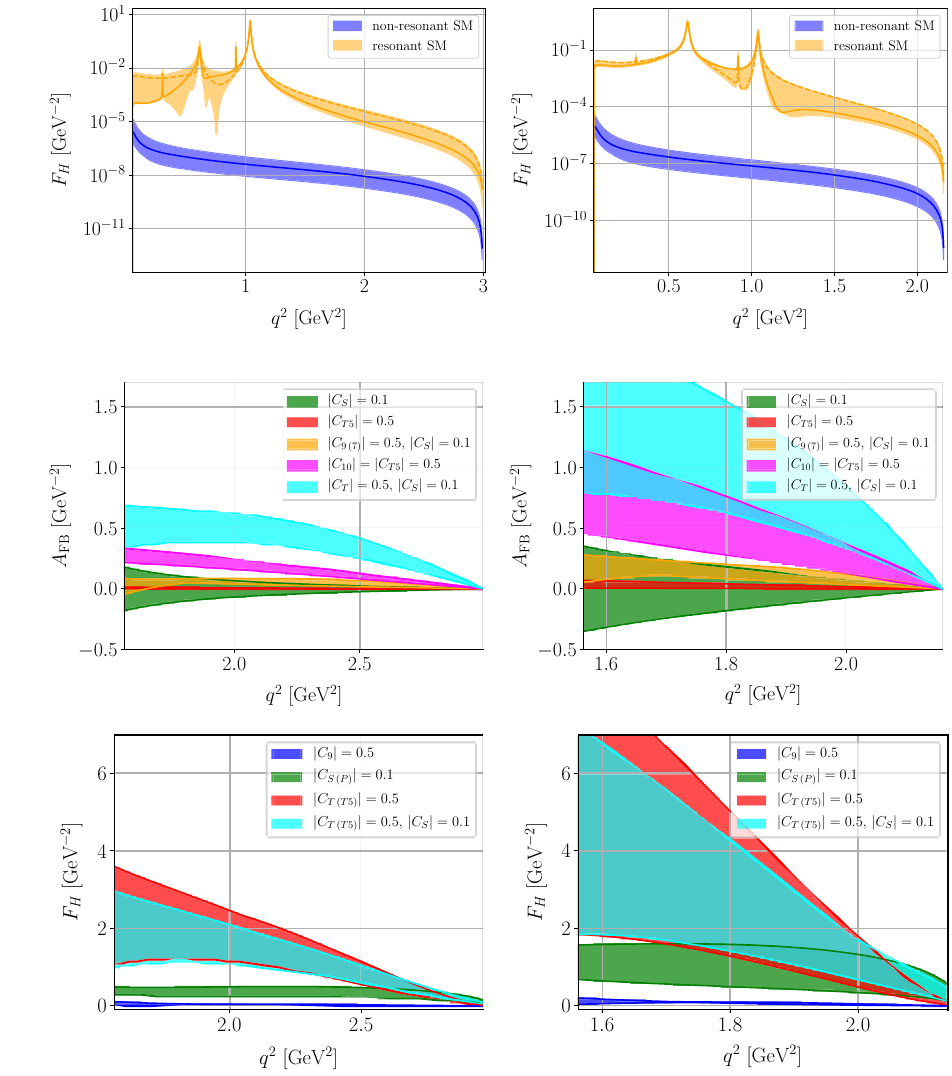
on the shape of the distributions. Choosing d (cid:11)/ dq 2 , as in [27], instead of (cid:11) (19), results in markedly different behav- ior for F H near the endpoint q 2 → ( m D − m P ) 2 ,